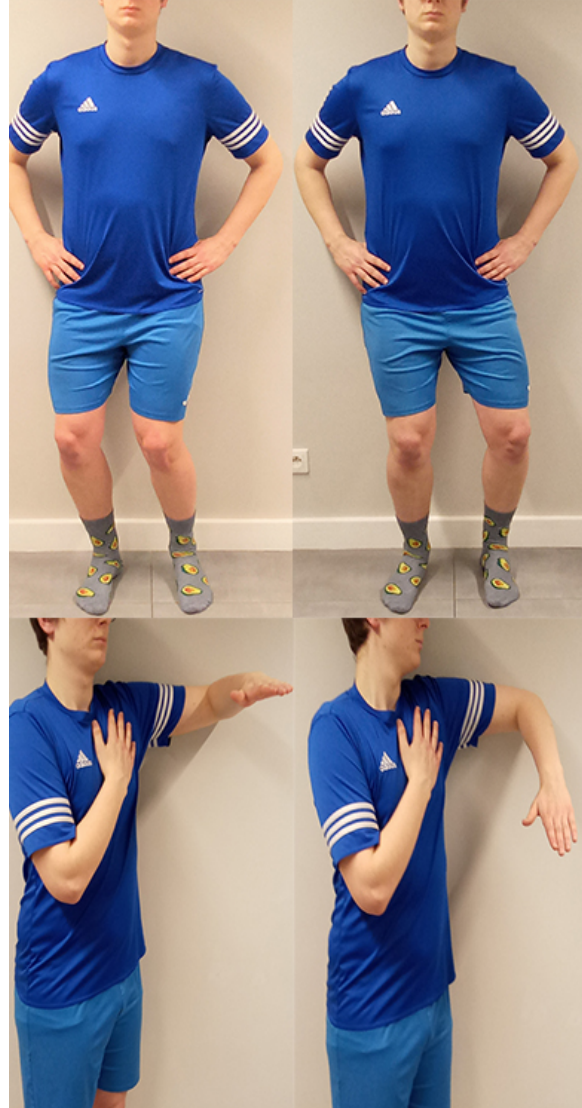
Fig. 1. Example of low threshold Performance Matrix Test.